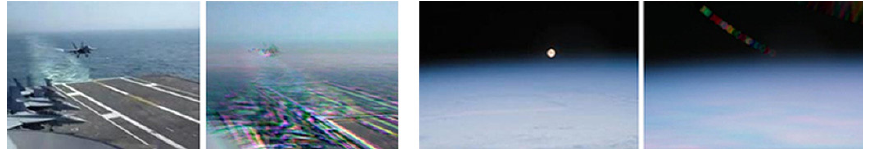
Fig. 1. Single frame predictions using an ANN model with two hidden layers. Left: ground truth target frame. Right: generated prediction